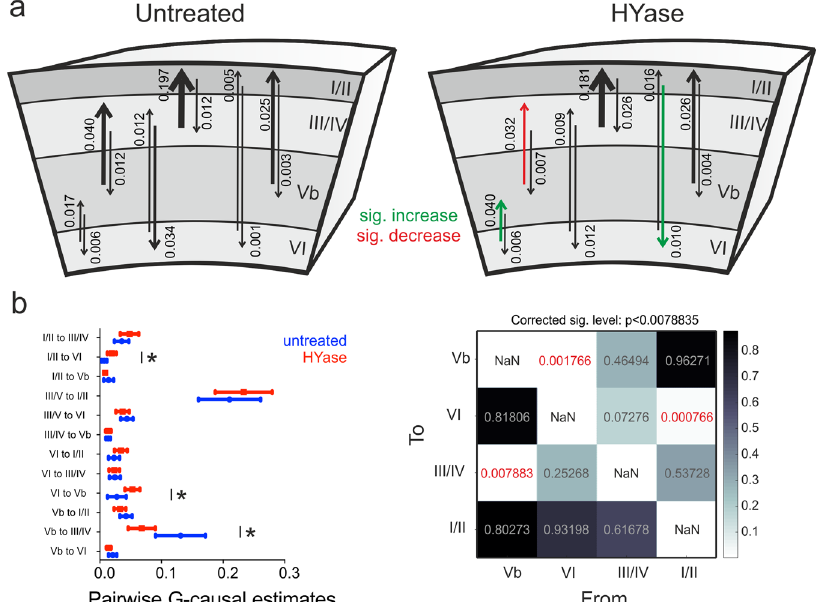
Fig. 5 Analysis of time-domain pairwise-conditional granger causality. Granger causality matrices were calculated based on the single trial CSD traces from each cortical layer for each subject ( n = 9). a Median values of the granger causality estimates between cortical layers are shown before ( left ) and after ( right ) HYase treatment. The cortical column scheme depicts the dynamics of the predictive causal relationship across different cortical layers before and after ECM removal. Arrow thickness indicates the median of the causal estimate weights across animals. Red and green arrows indicate where G- causal forecasting undergoes a signi fi cant reduction or increase after HYase treatment, respectively. b Comparison of the time-domain pairwise- conditional granger causality in the two conditions before and after HYase injection. Left . G-causal estimates were plotted with mean and standard error of the mean for each layer pairs from the 9 animals. Right , A multiple paired t-test was done on the log transformed values of the estimates and then corrected based on a false discovery rate of 0.05. Signi fi cant differences between G-causal measures indicated in the left plot correspond to a corrected level of signi fi cance after multiple comparisons of p <